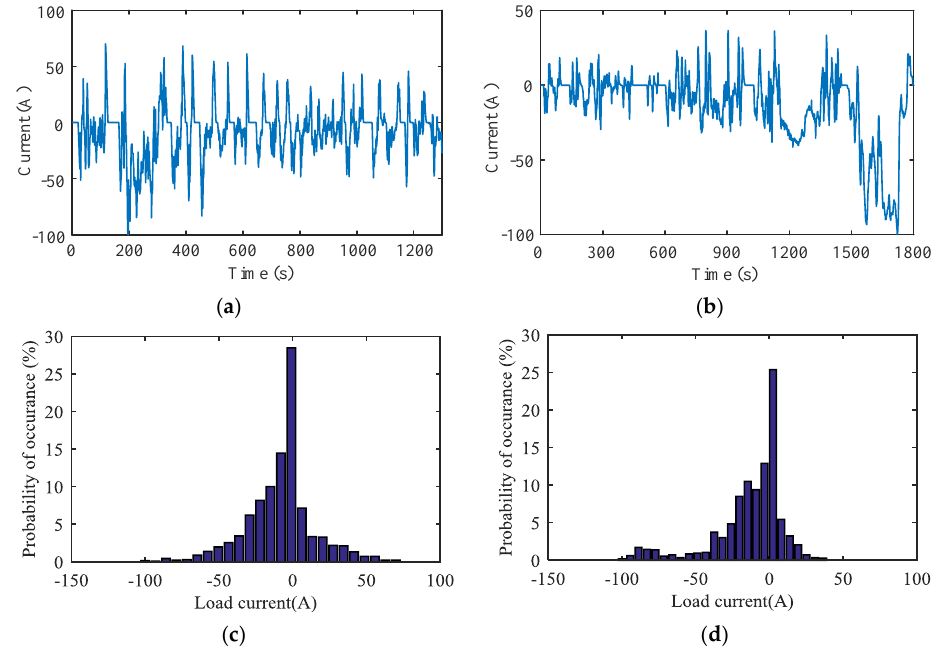
Figure 5. ( a ) The load current profile of the urban dynamometer driving schedule (UDDS) test; ( b ) the load current profile of the worldwide harmonized light vehicles test procedure (WLTP) test; ( c ) the load current amplitude distribution of the UDDS test; ( d ) the load current amplitude distribution of the WLTP test.